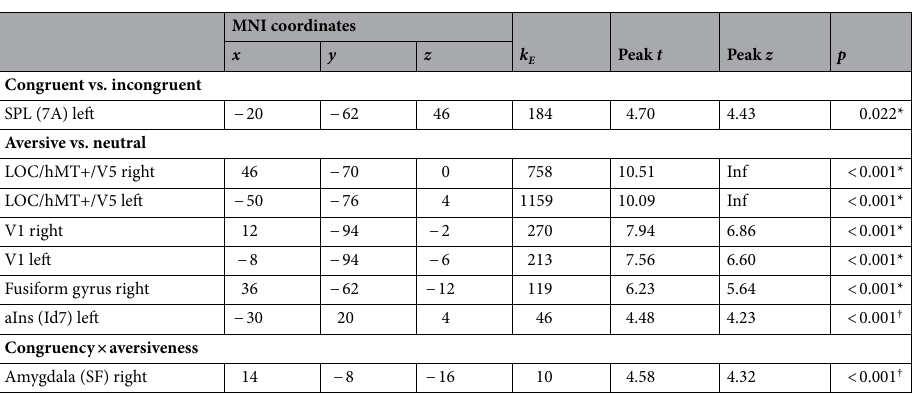
Table 1. Significant activation differences obtained from contrasting congruent versus incongruent visual-tactile stimulation, aversive versus neutral conditions, and the interaction between congruency and uncorrected within